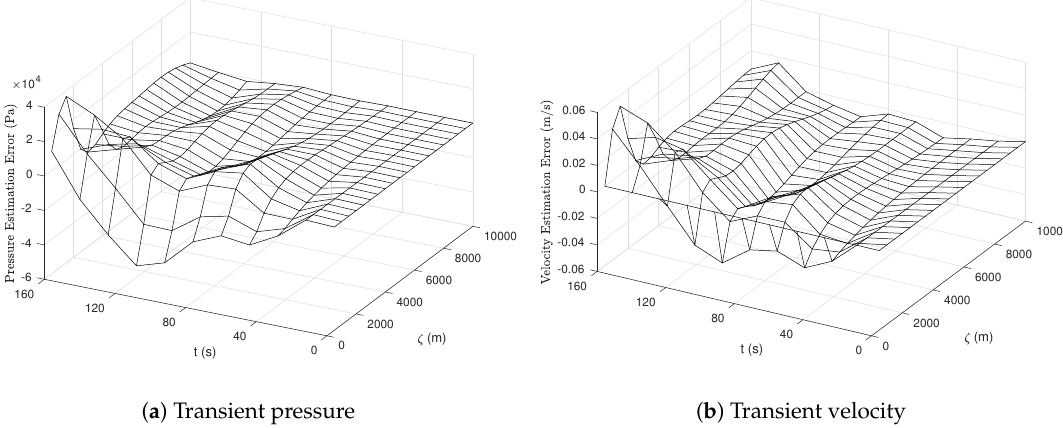
Figure 6. State estimation errors of the filtered water hammer system.